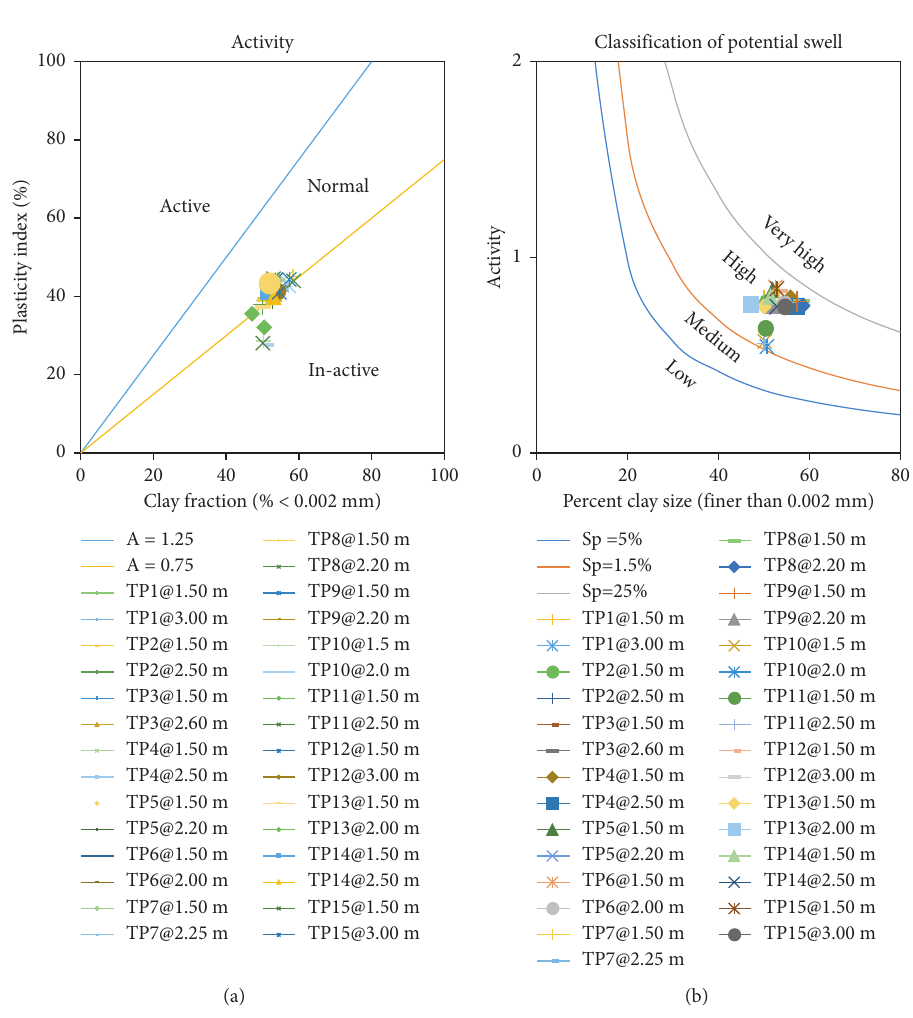
Figure 3: (a) Activities of clay soil and (b) expansiveness of clay soil by swelling potential. Table 4: Multiple regression analysis for swelling potential, Sp with